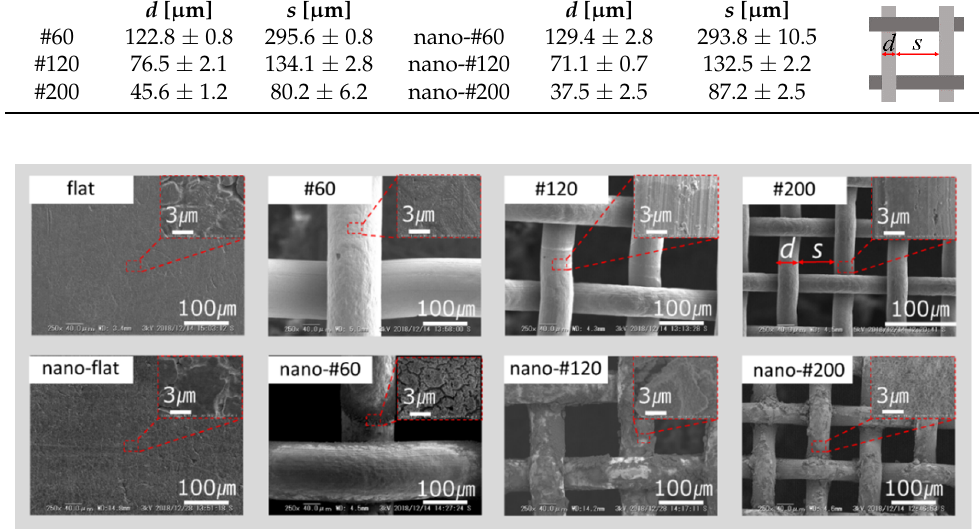
inch. Table 1 and Figure 2, respectively, show the dimensions and scanning electron mi- croscopy (SEM) images of the test wall. Here, the wire diameter and wire spacing are de- noted as d and s , respectively. Figure 2 shows that the nanocoated meshes have a nano order texture, thus forming a combined micro-nano structure. Table 1. Properties of mesh surfaces. d and s denote the wire diameter and wire spacing, respectively. d [μm]